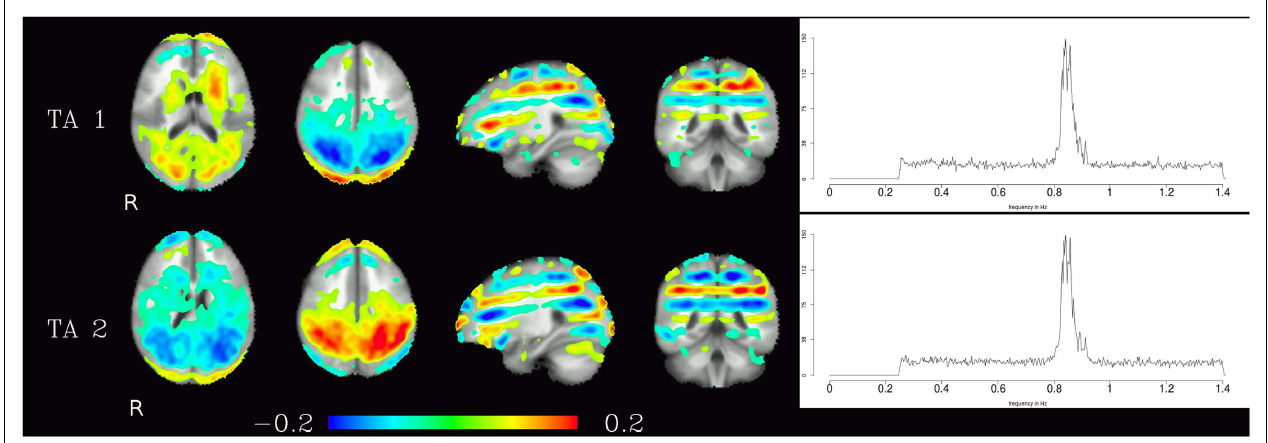
overlap with all other components, tICA is able to separate them from the other components due to the technical artifacts distinctive temporal characteristics (visible in their power